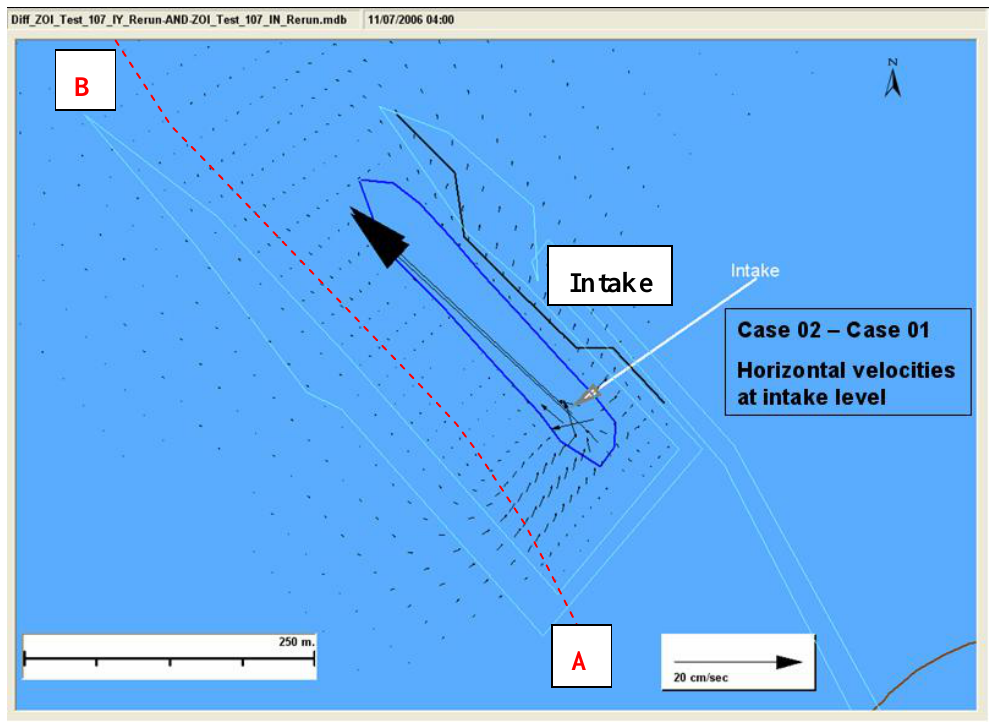
Figure 6. Horizontal velocities at intake for each